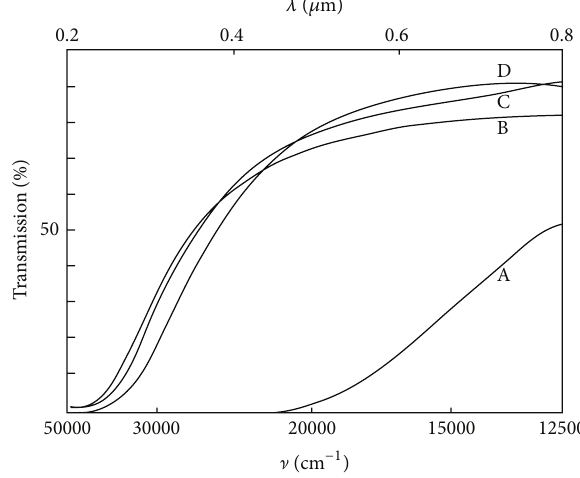
Figure 5: UV-visible transmission of aerogels with different pH: A (pH = 7), B (pH = 8), C (pH = 8,5), and D (pH = 9).